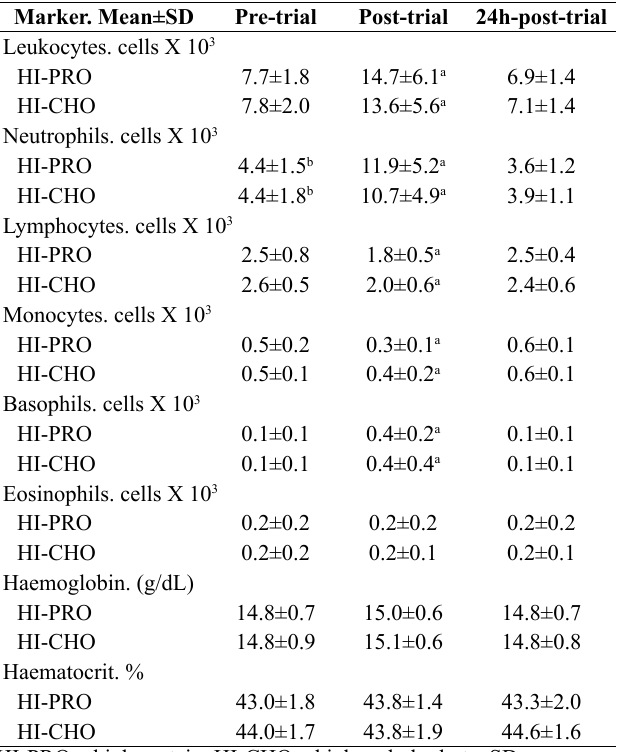
Table 1. White blood cells, haemoglobin and haematocrit concen- tration at the pre-, post- and 24h-post-trial in HI-PRO and HI-CHO conditions.